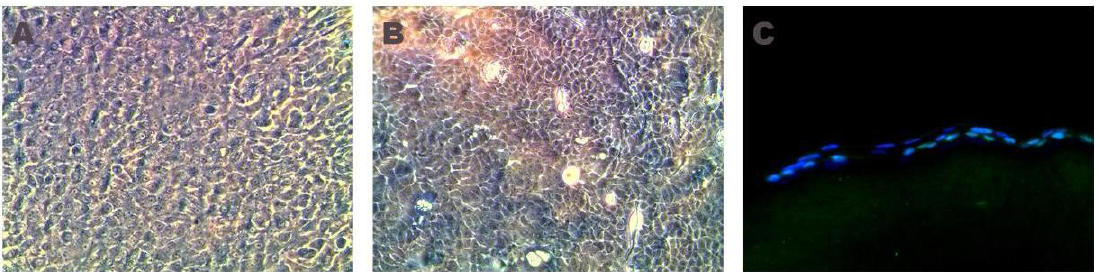
Figure 1. Phase-contrast microscopy of autologous ( A ) or heterologous ( B ) rabbit LEPCs cultured on a fibrin-PRGF mem- brane displaying their typical polyhedral morphology. Immunofluorescence analysis of fibrin-PRGF membranes cultured with rabbit LEPCs for p63 in green and DAPI in blue ( C ). 100 × (phase-contrast microscopy) and 400 × (immunofluorescence). Group 1: only medical treatment (control group), Group 2: fibrin-PRGF membrane cultured with autologous rabbit LEPCs, Group 3: fibrin-PRGF membrane cultured with heterologous rabbit LEPCs, Group 4: fibrin-PRGF membrane SLET and Group 5: fibrin-PRGF membrane without rabbit cultured LEPCs. PRGF: Plasma Rich in Growth Factors, LEPCs: Limbal Epithelial Progenitor Cells, SLET: Simple Limbal Epithelial Transplantation.